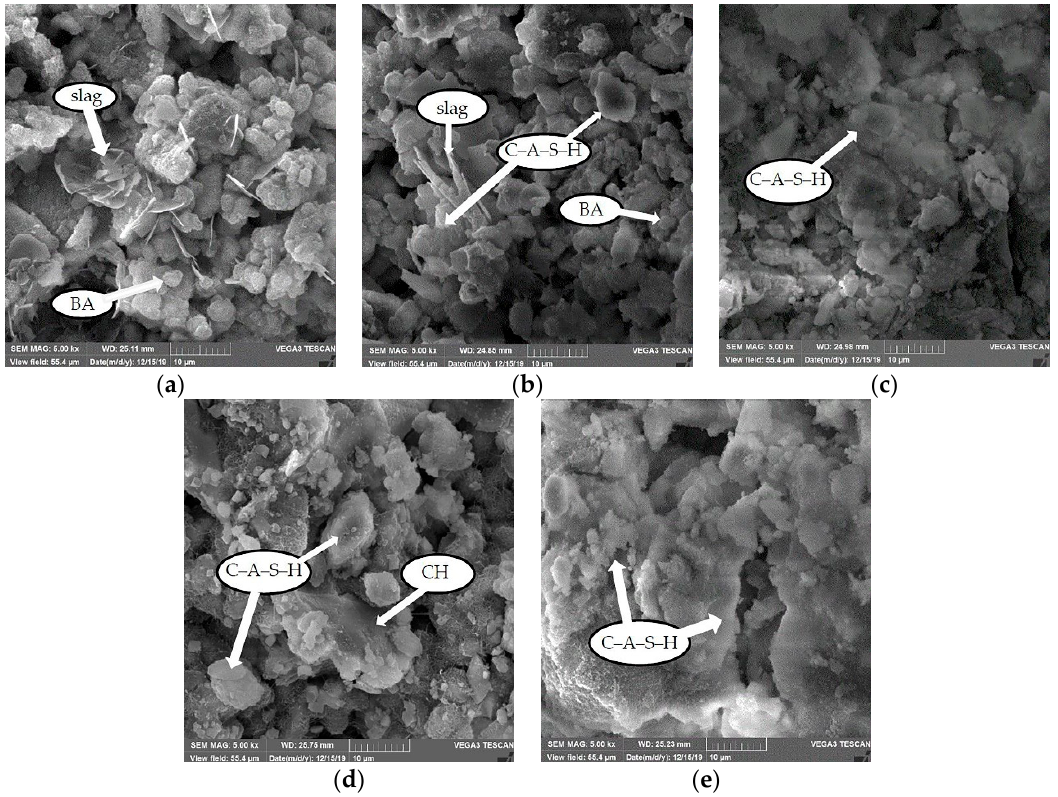
Figure 8. SEM micromorphology of samples at different curing ages (5000× magnification): ( a ) 1 d, ( b ) 3 d, ( c) 7 d, ( d ) 14 d, and ( e ) 28 d.